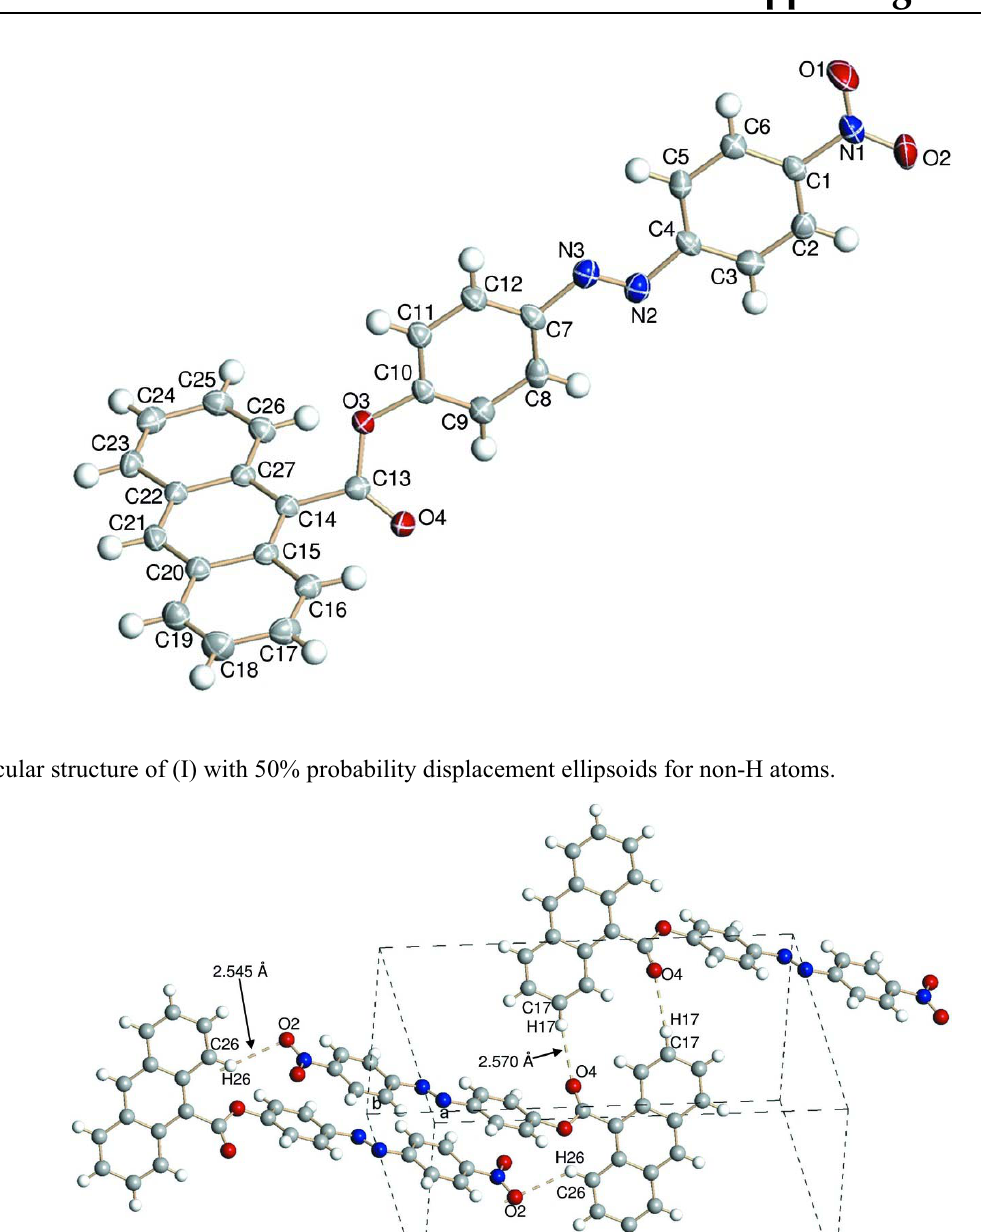
sup-2 Acta Cryst. (2008). E 64 , o2258